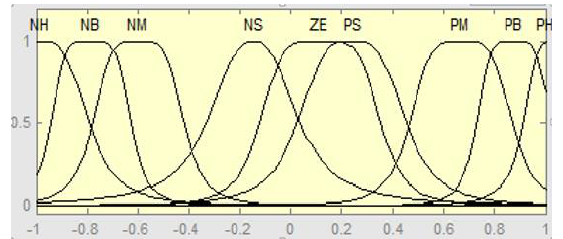
Figure 16. Network simulation